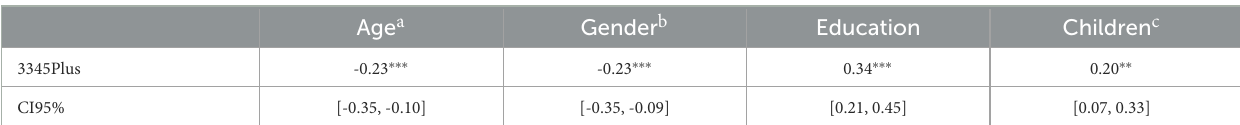
TABLE 6 3345Plus correlation with sociodemographic data ( N = 208).